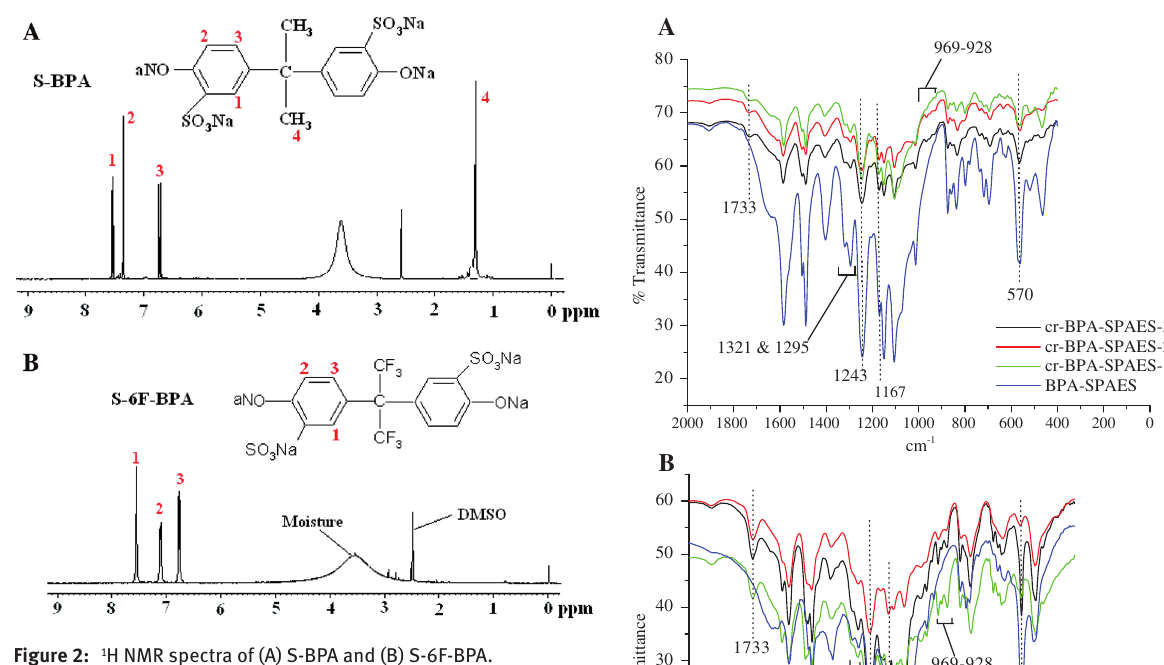
Figure 4A and B represented the 1 H NMR spectra of 6F-SPAES and BPA-SPAES copolymers, respectively. The methyl protons (H ) of DPA appeared at 1.6 ppm and the 10 methylene protons (H , H ) of the pentanoic group of DPA 9 8 showed resonating signals at 2.0 ppm and 2.5 ppm, respec- tively. The methyl protons (H ) of BPA appeared at 1.3 ppm. 11 The aromatic protons (H , H ) attached to the ortho positions 1 3 of the electron withdrawing groups (sulfone and sodium sulfonate) appeared in the lower field region (7.9–8.0 ppm)